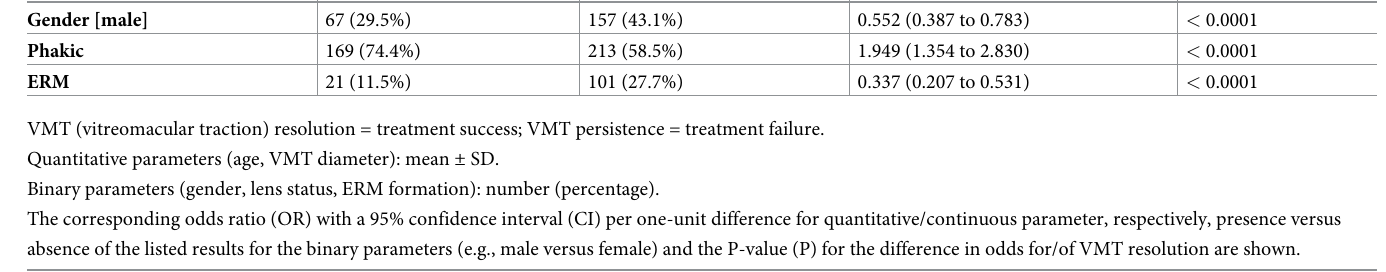
In the next step, the calibration was investigated. The calibration of the model was relatively good (p < 0.001 for testing differences from β = 1). The resulting ‘calibration belt’ is given in 1 Fig 2. The calculated factors β (-0.352) and β (0.827) were used to calibrate and consequently 0 1 improve the model. The parameters of the resulting ‘calibrated model’ are displayed in Table 2. To judge the robustness of the model, a multivariable model generation was per- formed using the pool of 591 patients. The parameters of the newly formed model (‘recalculated model’) are described in Table 2, as a comparison to the original model from the EXPORT study. Of interest, there was a minimal increase in the influence of age (OR age: 0.92 vs 0.93), yet some decrease for the VMA-diameter (OR ln(VMA-diam- eter): 0.61 vs 0.38). To envision the developed multivariable model, patients were grouped by their predicted probability of IVO success in 25% intervals. The assignment to these groups, dependent on the age and horizontal diameter of each patient, were computed with Eq (1) and Eq (2) with the respective parameters (Table 2). For the calibrated EXPORT model this assignment is visual- ized in Fig 3. In each group, the mean observed success rate was calculated (Fig 4). It was within the calculated range for both models–with both variants a prediction of treatment suc- cess was possible. Of note, the ROC curve for both the original EXPORT model and the cali- brated EXPORT is the same, as the ROC analysis is not affected by the monotonous transformation in the calibration process.